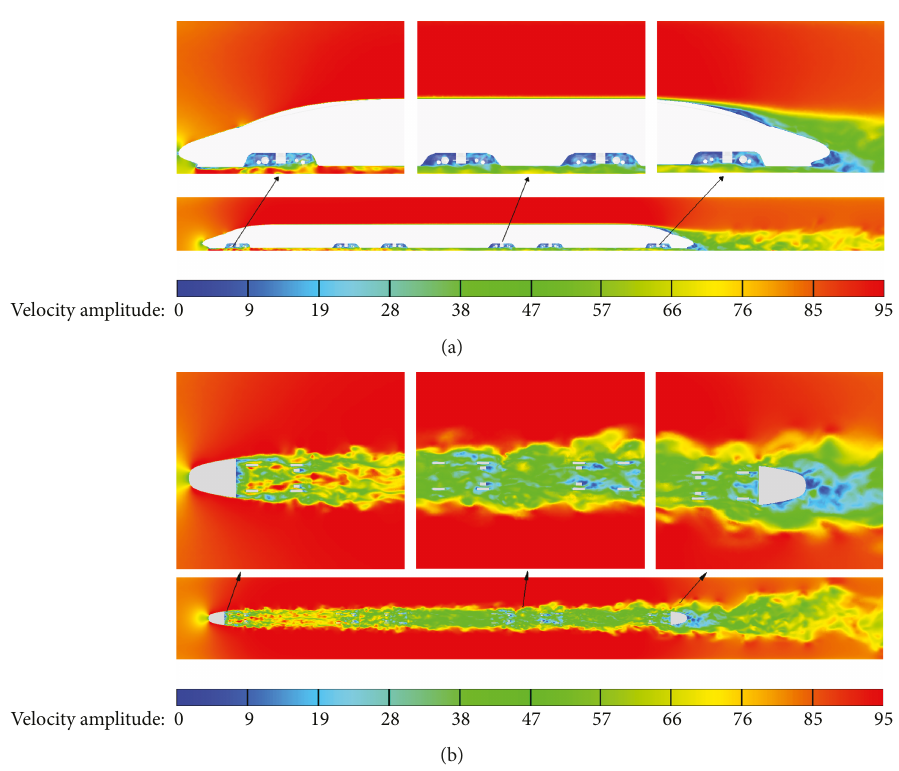
Figure 9: Velocity amplitude (units: m/s; free fl ow speed: 83m/s): (a) longitudinal symmetry plane of the train and (b) x - y plane that is 0.1 m above the